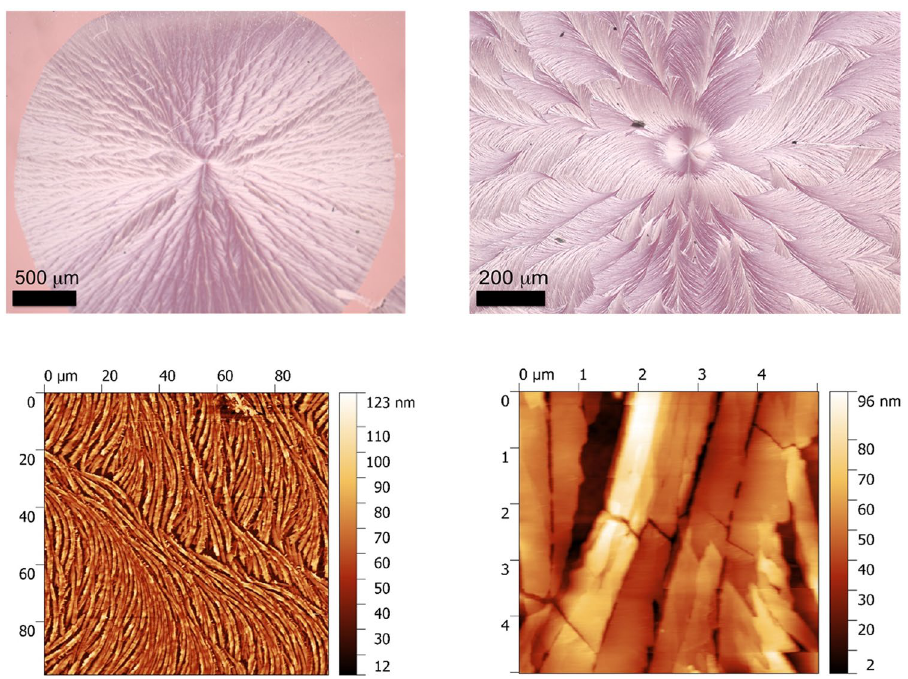
Figure 6. Top: optical micrographs of a thermally crystalized fiFClm of D on PEDOT:PSS coated ITO; bottom AFM images of the same